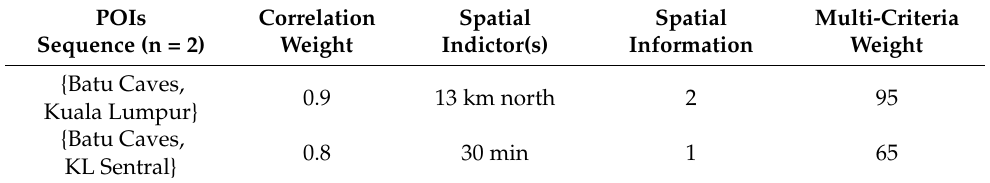
Table 7. Multi-criteria weight for